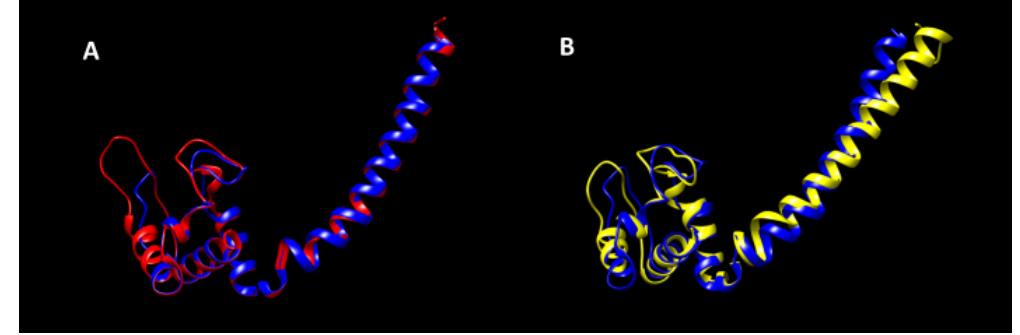
Figure 3. Comparative of the predicted structures of Cyt c M and NorC. ( A ) shows the predicted structure for Cyt c M by Phyre 2 (blue) vs. NorC (red) while ( B ) shows the same prediction (blue) vs. the one by I-TASSER (yellow). In both panels, the structure predicted by Phyre 2 is the one for Cyt c M of Nosto c sp. PCC 7120, as in Figure 2.